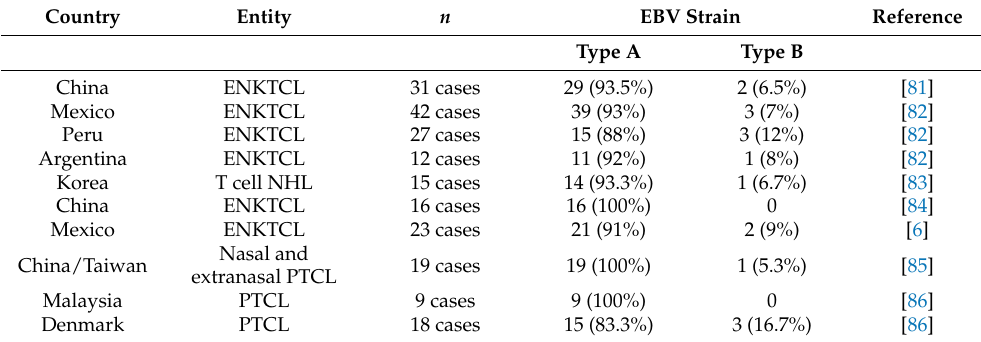
Table 1. Geographical distribution of Epstein-Barr virus (EBV) strains in T cell non-Hodgkin lym- phoma. Country Entity n EBV Strain Reference Type A Type B China ENKTCL 31 cases 29 (93.5%) ENKTCL